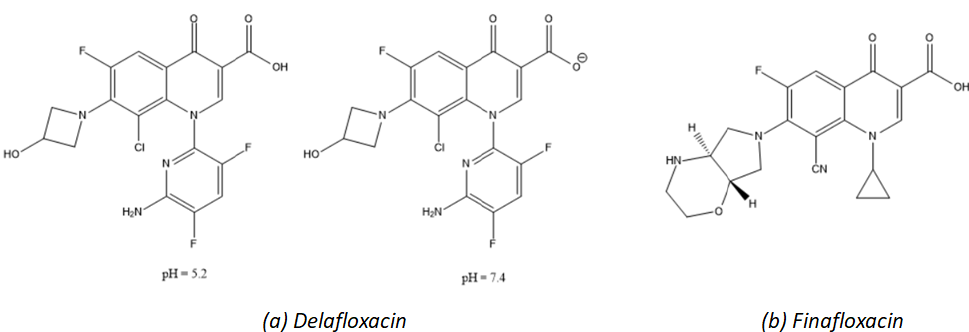
Figure 4. ( a ) Influence of pH on the chemical formula of delafloxacin. ( b )